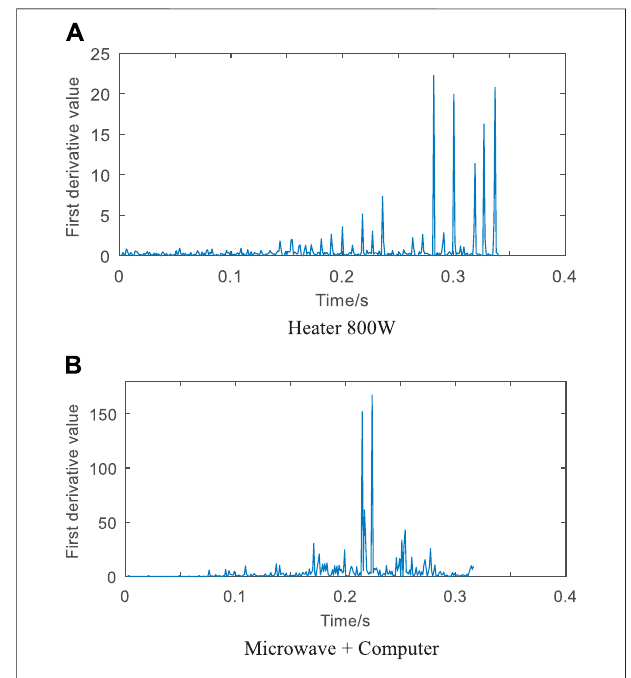
FIGURE 5 | First derivative of the correlation coef fi cient r for different loads. (A) Heater 800 W. (B) Microwave +